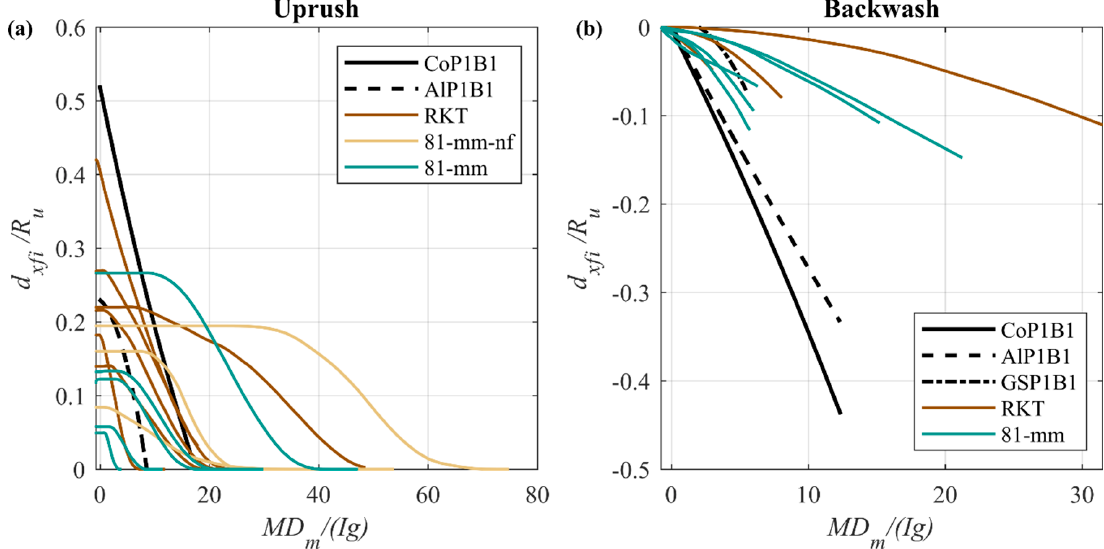
Figure 20. Comparison between the flume and field cross-shore distance travelled and moment dimensionless groups for uprush ( a ) and backwash ( b ). Only field munitions that were mobilized are reported in this figure.